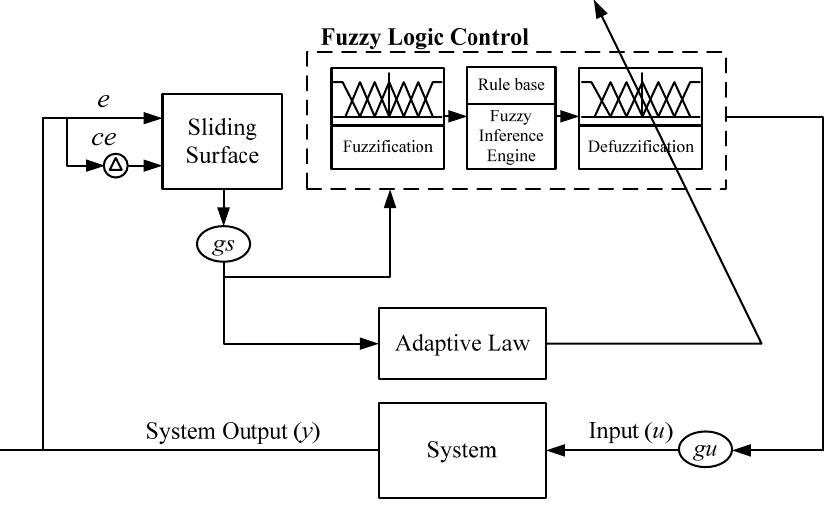
Figure 2. Block diagram of adaptive fuzzy sliding mode control system.